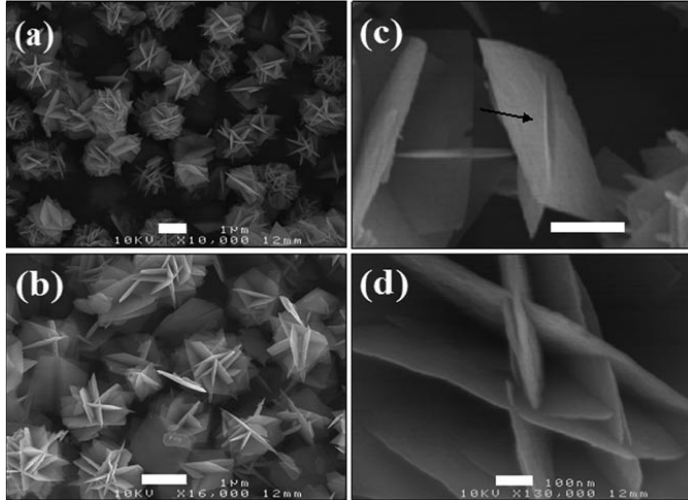
Figure 10. SEM images of the flowerlike TiO (scale bars in a – d are 1 mm, 1 mm, 0.5 mm and 100 nm, respectively). Reprinted from ref. [67] with permission of